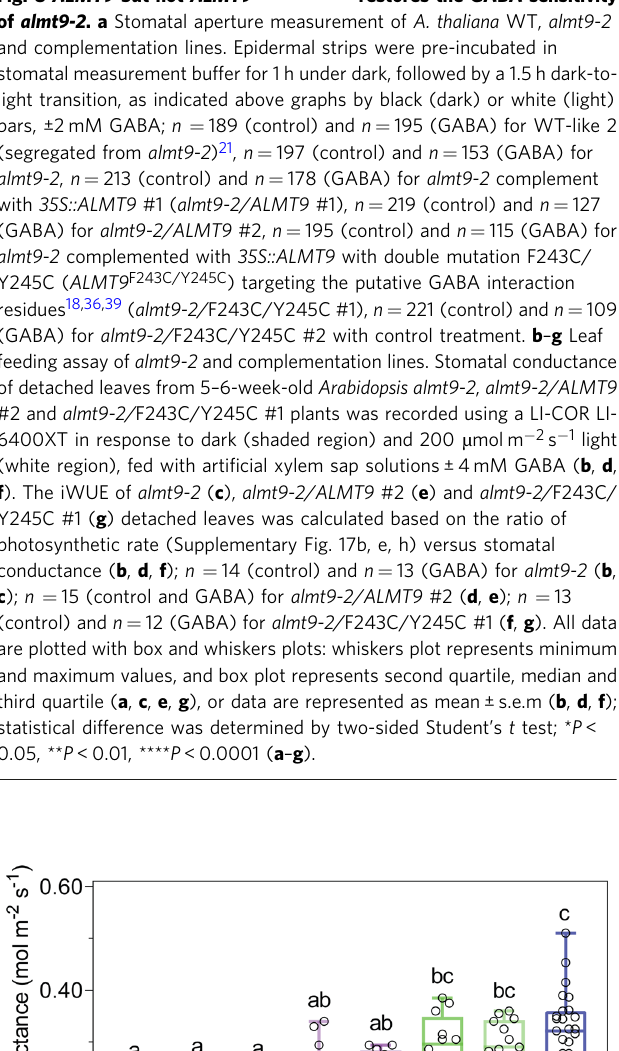
Fig. 9 ALMT9 F243C/Y245C increases steady-state stomatal conductance. Stomatal conductance of 5 – 6-week-old Arabidopsis WT, gad2-1 , a lmt9 -2 and complementation lines determined using an AP4 Porometer; n = 18 for WT, n = 12 for WT-like 2, almt9-2/ALMT9 #2 and almt9-2/ F243C/Y245C #1, n = 13 for almt9-2 , almt9-2/ALMT9 #1 and almt9-2/ F243C/Y245C #2, n = 27 for gad2-1 . All data are plotted with box and whiskers plots: whiskers plot represents minimum and maximum values, and box plot represents second quartile, median and third quartile; statistical difference was determined by one-way ANOVA, the letters a, b and c represent data groups that are not statistically different, P <